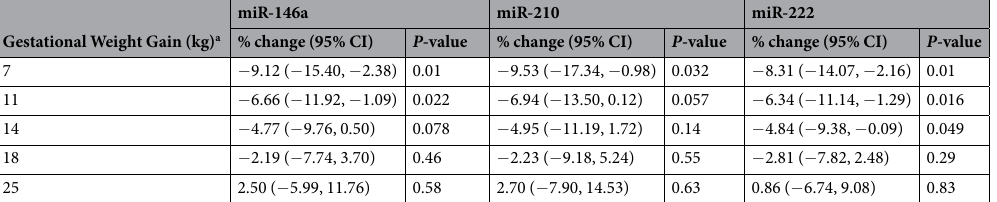
Table 4. Changes (%) in placental miRNA (miR-146a, miR-210 and miR-222) expression in newborn girls in association with pre-pregnancy BMI at specific gestational weight gain values. Estimates (95% confidence intervals) are given for a 1 kg/m 2 increase in BMI and adjusted for newborn’s ethnicity and gestational age, maternal age, smoking status, educational status, parity, gestational weight gain, interaction between pre-pregnancy BMI and gestational weight gain, health complications, delivery by C-section and outdoor temperature during third trimester. a The gestational weight gain (kg) is indicated for 5 th , 25 th , 50 th , 75 th and 95 th